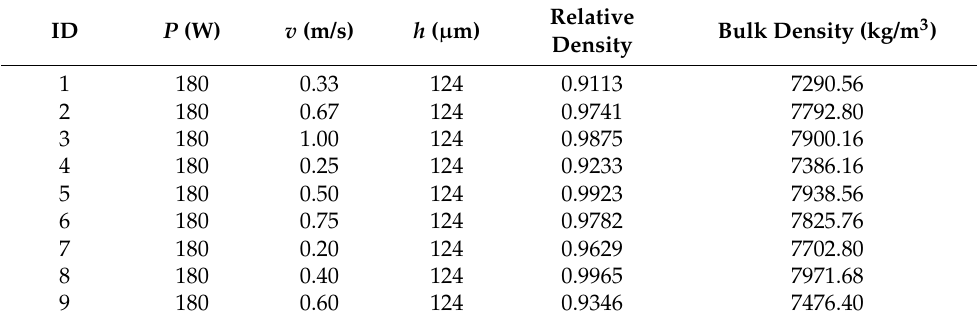
Table A8. Manufacturing parameters and experimental data adapted from [22]. Complement- ing relevant information and assumptions are the following; material: SS316L, theoretical density